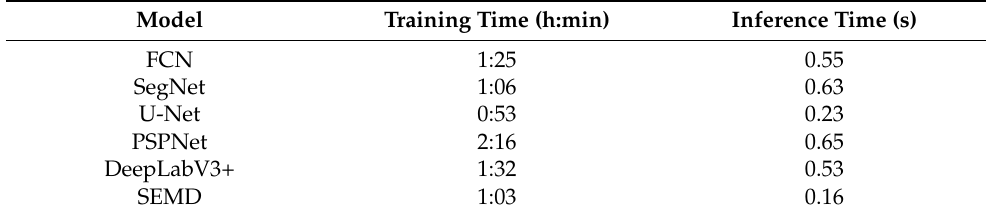
Table 9. Average processing time for each method.